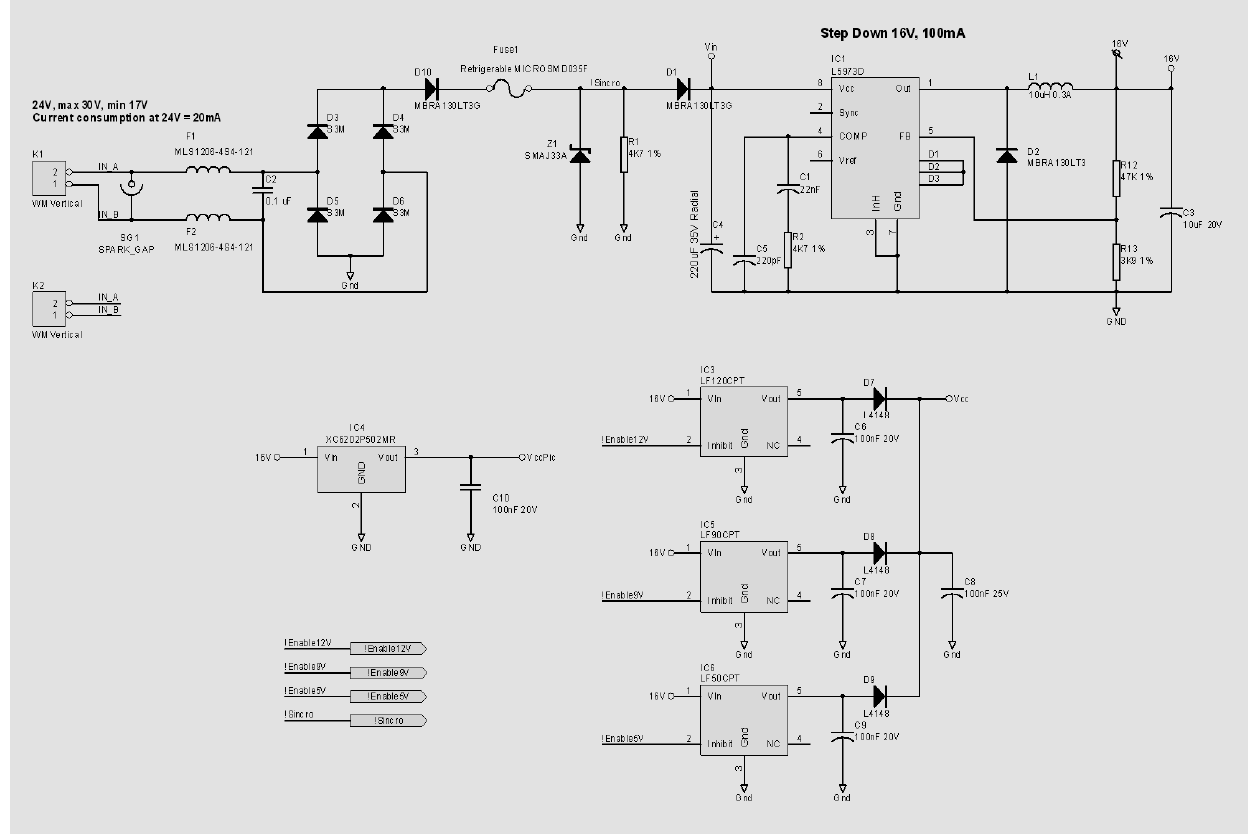
Figure 8 . Voltage